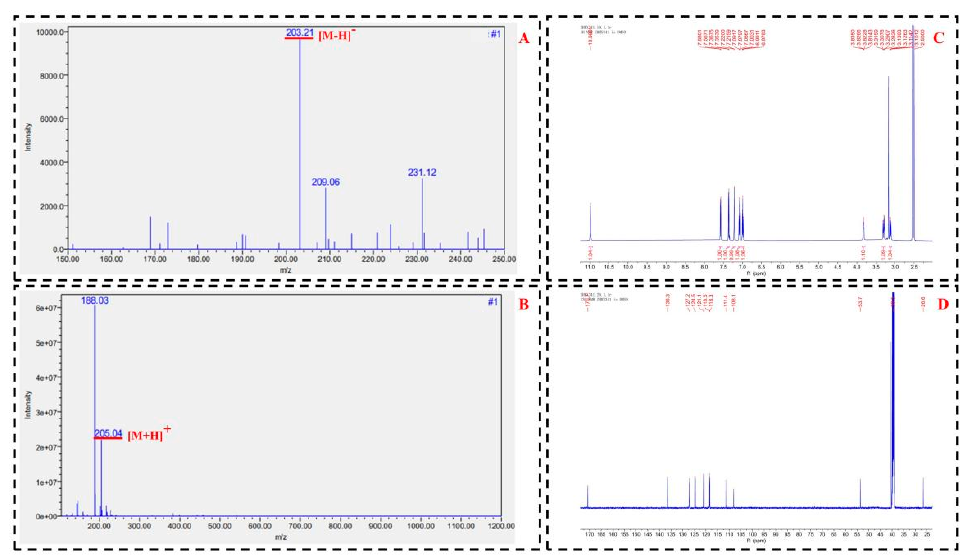
Figure 5. ( A , B ) Q − TOF − MS spectra of Fr341; ( C ) 1 H NMR spectra of Fr341; ( D ) 13 C NMR spectra of Fr341.